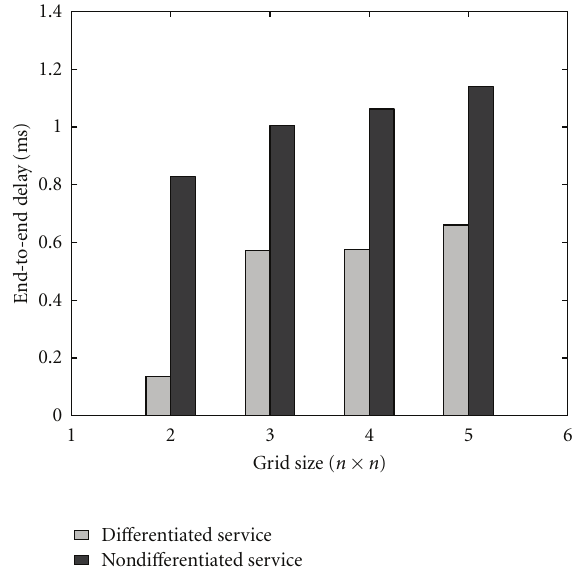
Figure 10: Delay comparison: delay sensitive versus best e ff ort.